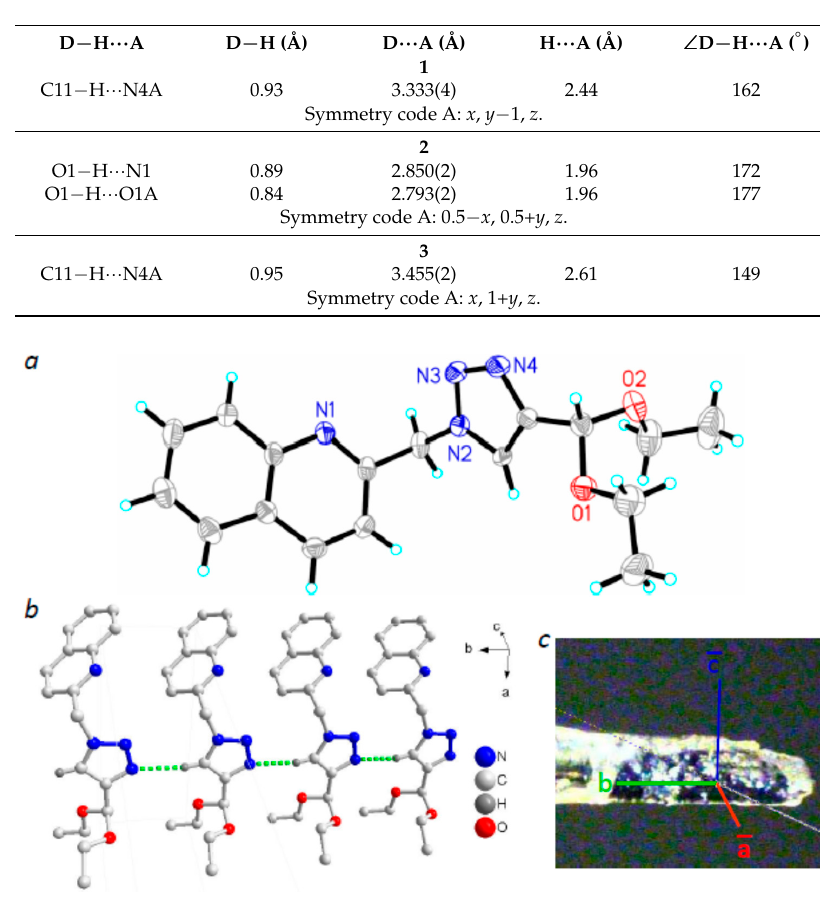
Figure 1. Molecular structure of 1 ( a ). H-bond interactions in 1 ( b ). Crystal image with lattice directions of 1 ( c ).